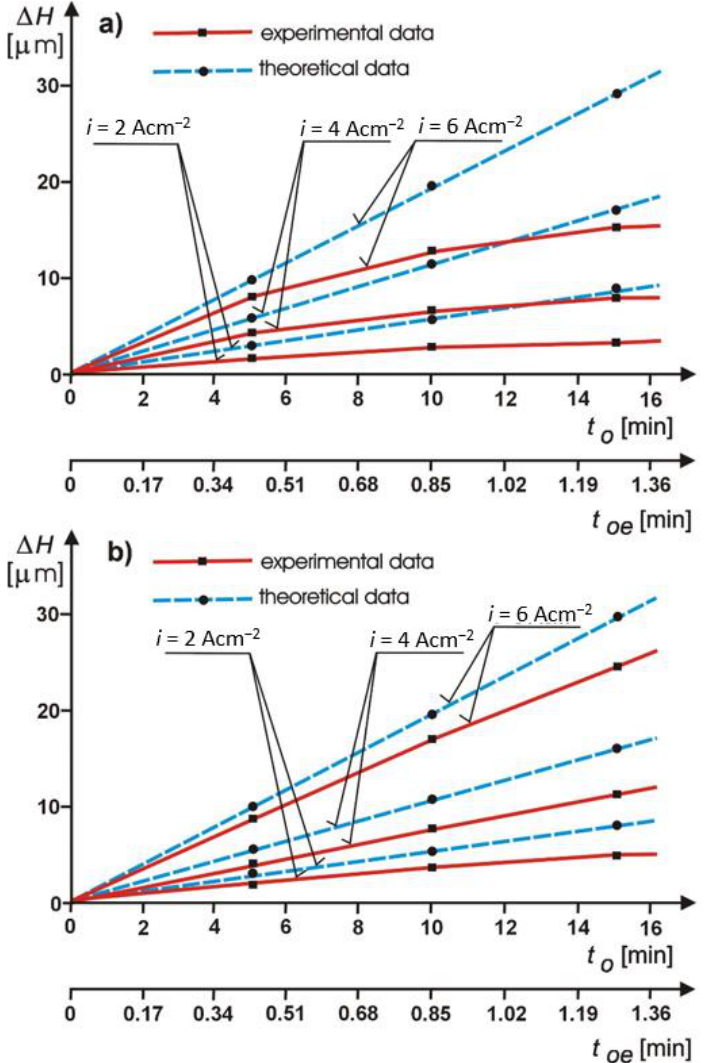
Figure 10. A comparison of the theoretical calculations and the experimental investigations of the grinding layer ΔH removed in the ECDGW-AC dressing process: ( a ) Dressing with a stationary electrode; ( b ) Dressing with a step feed electrode.